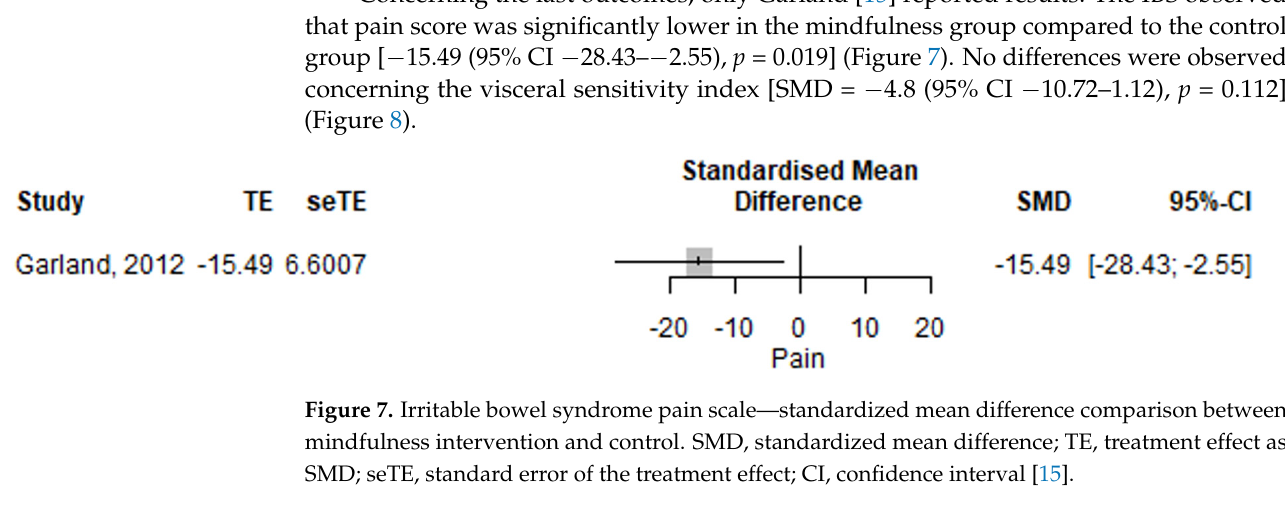
Figure 6. Irritable bowel syndrome anxiety scale—standardized mean difference comparison be- tween mindfulness intervention and control. SMD, standardized mean difference; TE, treatment effect as SMD; seTE, standard error of the treatment effect; CI, confidence interval [15,17].